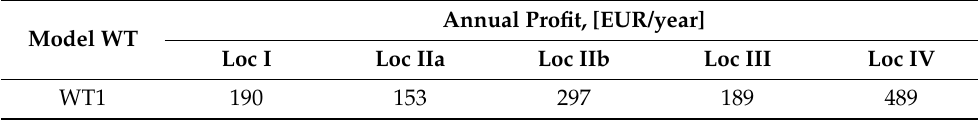
Table 3. Annual profit from the sale of energy delivered to the electricity grid. Model